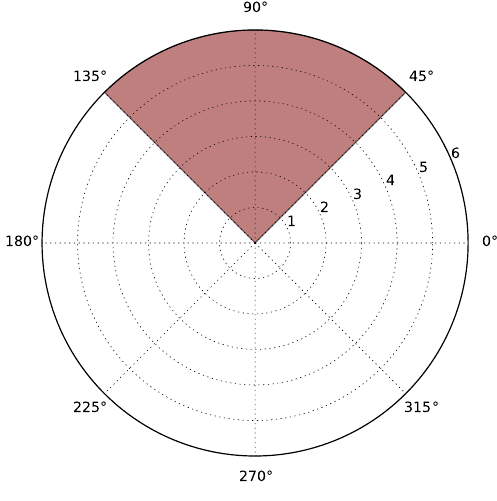
Figure 2. One of four long-range directional wake-up radios’ (LDWuRs) scans the north